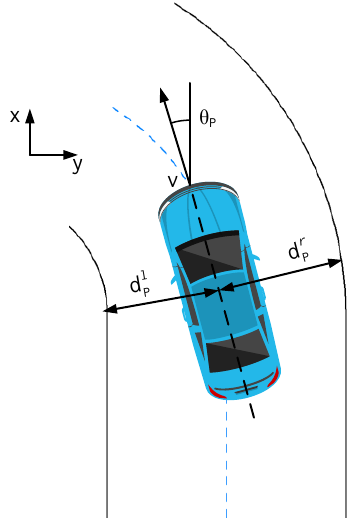
Figure 4. Lane path modeling.